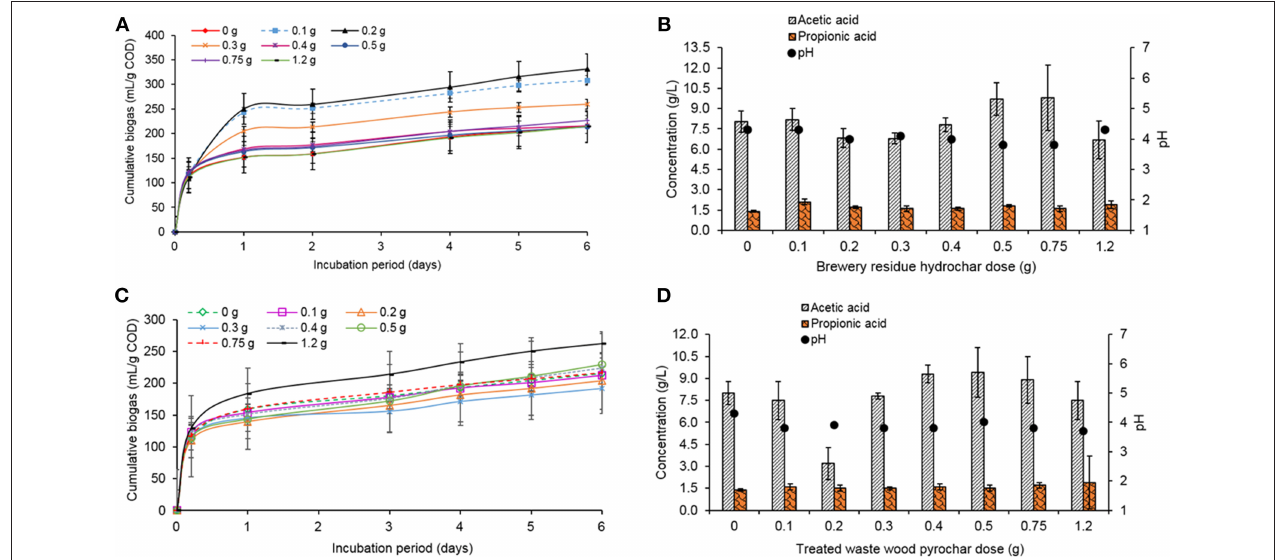
FIGURE 4 | (A) Cumulative biogas production during the treatment with different doses of the brewery residue hydrochar, with 1M NaOH, (B) Production of acetic and propionic acid in the treatments with the brewery residue hydrochar, with 1M NaOH (incubation period: 6 days), (C) Cumulative biogas production during the treatment with different doses of the treated waste wood pyrochar, with 1M NaOH, and (D) Production of acetic and propionic acid in the treatments with the treated waste wood pyrochar, with 1M